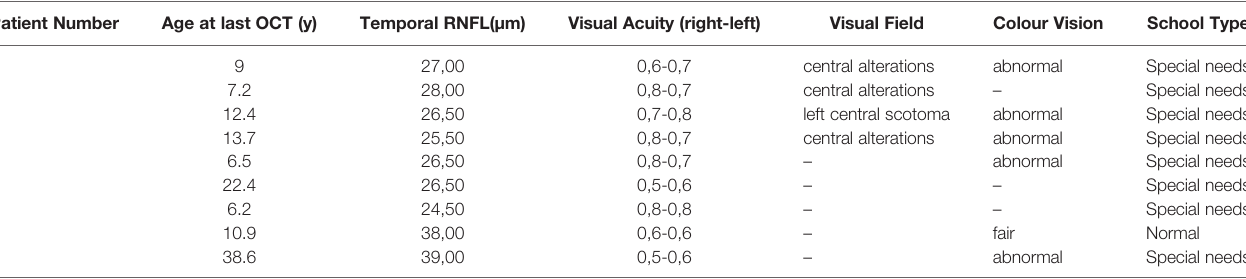
TABLE 2 | Ophthalmological data and school type of the 9 patients with Triple A syndrome whose neurological status allowed an in-depth investigation. Patient